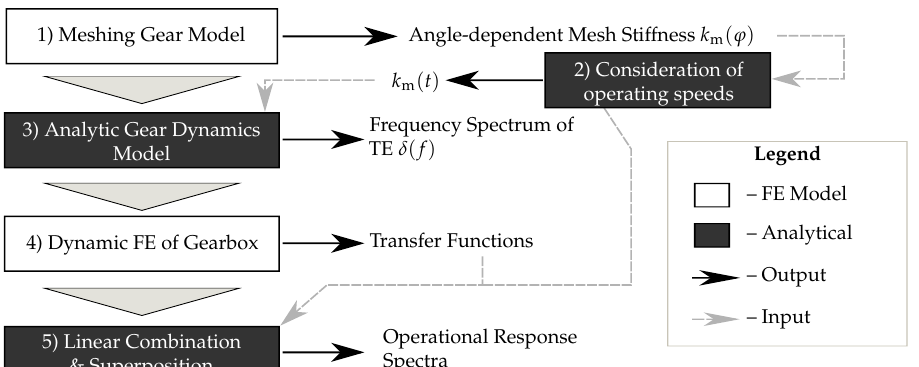
Figure 1. Schematic overview of the integrated computational procedure. In the first step, static FE simulations of gears in contact provide the angle-dependent mesh stiffness k m ( ϕ ) . The angle- dependent mesh stiffness is then transformed to the TVMS k m ( t ) , while varying operating speeds are considered by both kinematic and kinetic effects. The TVMS k m ( t ) is applied in an analytical two-body model of the transient gear dynamics to obtain the dynamic transmission error δ . The frequency spectra of the operational gearbox response are calculated by an analytical combination of the excitation spectra δ ( ω ) and transfer functions, which have been computed independently using a detailed FE model of the